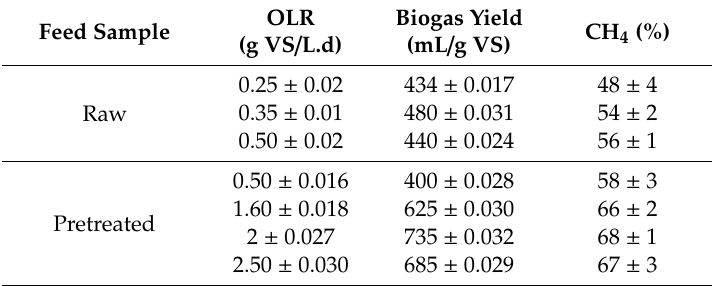
Table 3. Evolution of organic loading rate (OLR), biogas yield and methane percentage during anaerobic digestion of raw and pretreated sludge in UASB reactor.